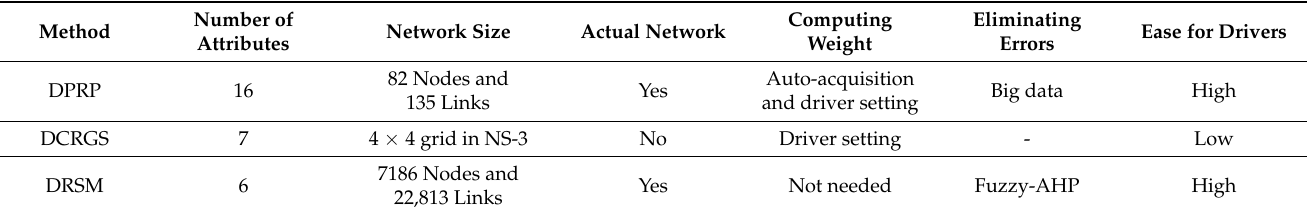
Table 11. Comparison of different